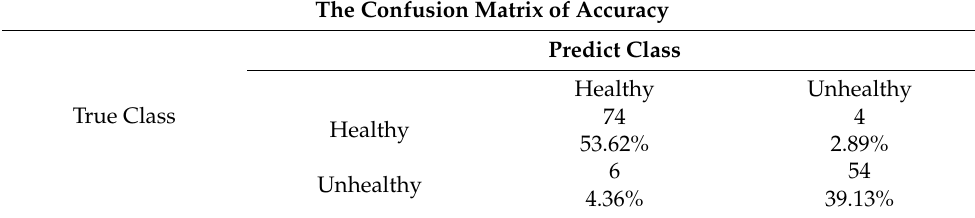
The Confusion Matrix of Accuracy